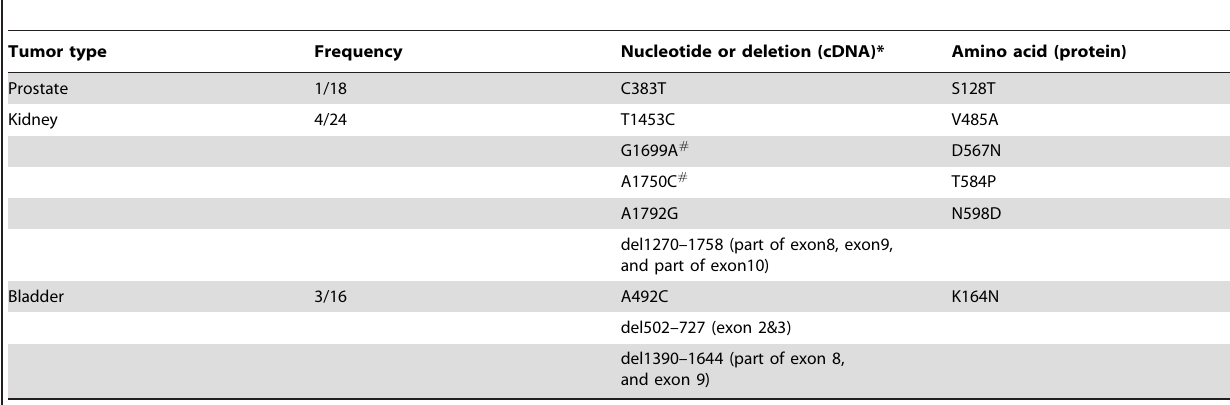
Table 1. Mutations in FBXW7 gene in urological cancer from Chinese